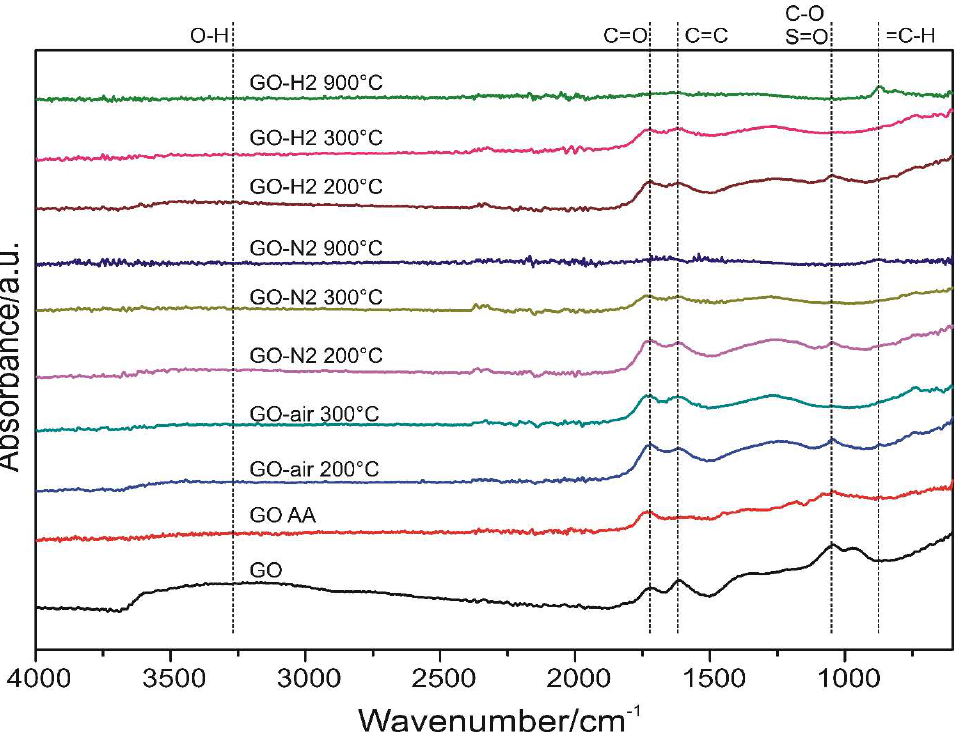
Figure 6. ATR spectra of the samples with the peaks marked.